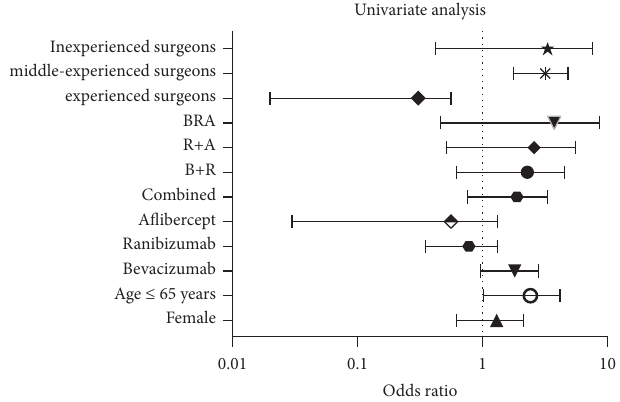
Figure 1: Predictors of posterior capsular rupture (PCR). The odds ratio with 95% confidence intervals is shown from the univariate analysis. The dotted line represents no difference in risk from the reference group within each predictor variable. The logarithmic notation was employed for scale representation of the odds